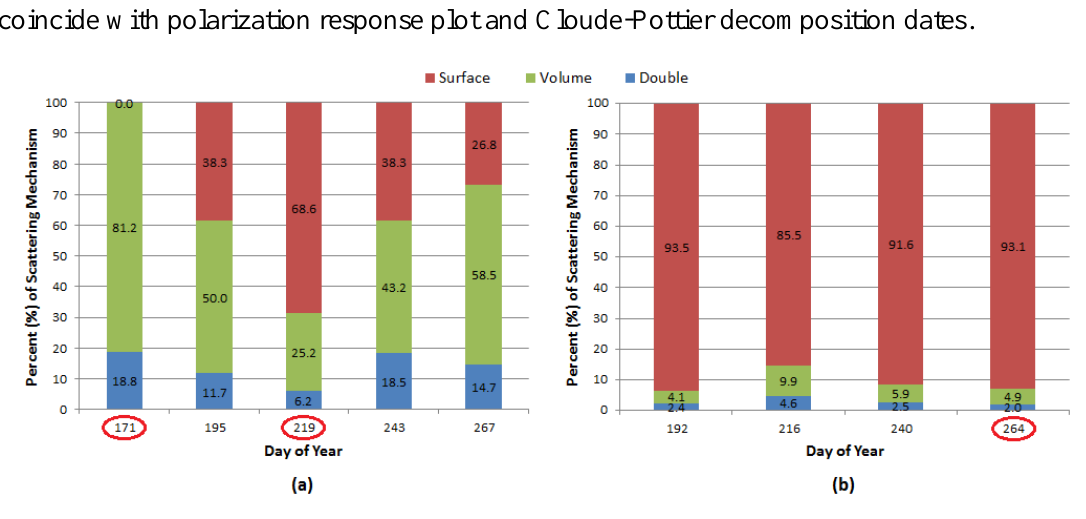
Figure 15. Wetlands co- (Left) and cross-polarization (Right) polarimetric response plots based on RADARSAT-2 fine-quad beam modes for 20 June ( a , b ); 4 August ( c , d ); and 24 September ( e , f